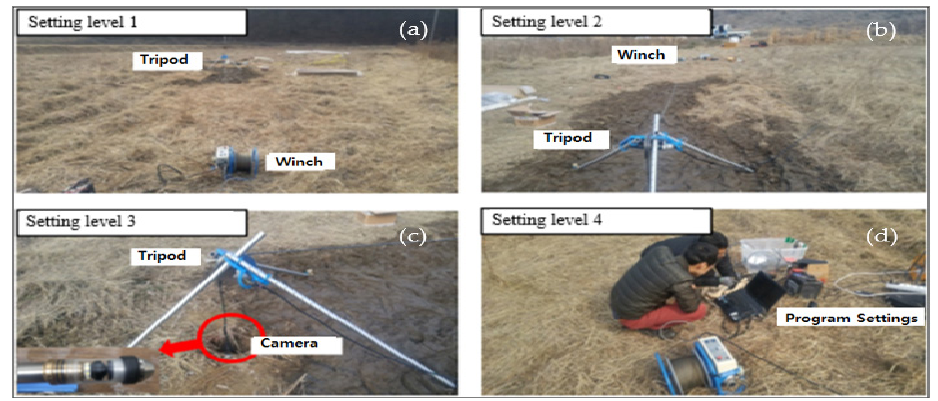
Figure 23. BIPS implementation in the study area, ( a ) Setting level 1, ( b ) Setting level 2, ( c ) Setting level 3, ( d ) Setting level 4.